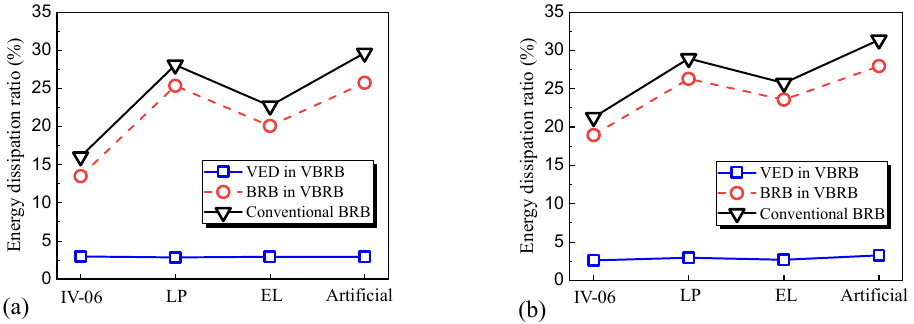
Figure 15. Seismic energy analysis (Loma Prieta case, PGA = 620 cm/s 2 ): ( a ) energy distribution (VBRB-BF); ( b ) energy absorbed by components (VBRB-BF); ( c ) energy distribution (BRB-BF); and ( d ) energy absorbed by components (BRB-BF).